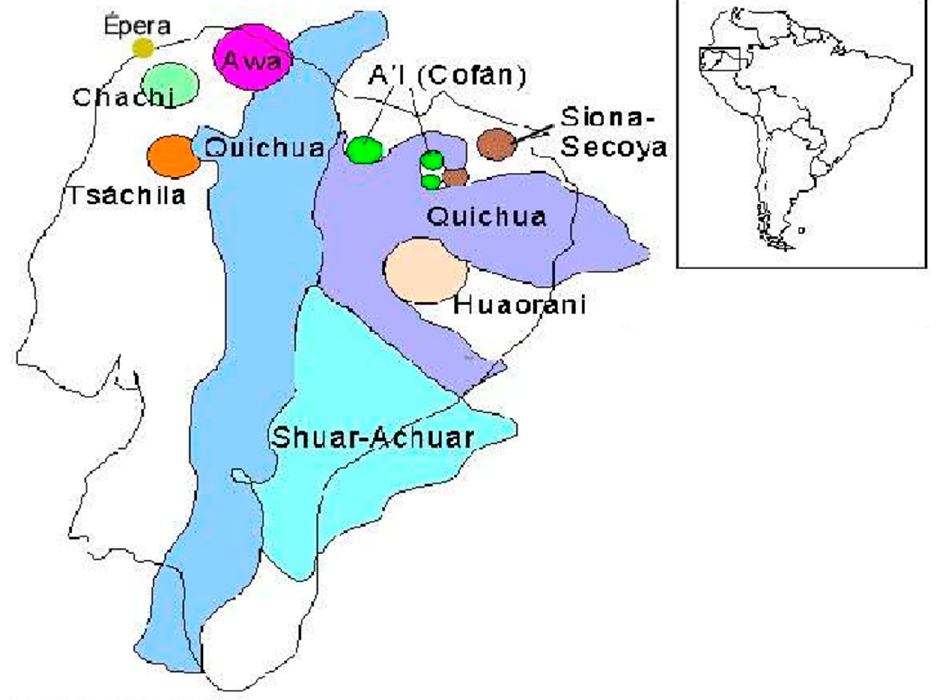
Figure 9. Map of indigenous languages in Ecuador. Available online: https://blogs.covchurch.org/delp/?p=1822 (accessed on 20 November 2021).